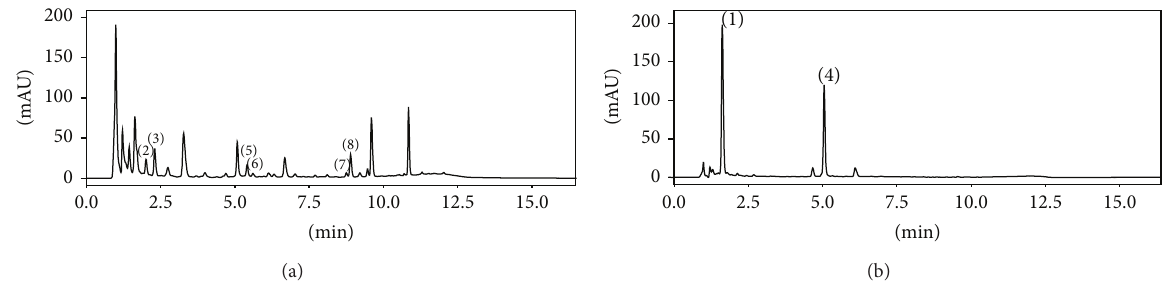
Figure 2: HPLC-DAD chromatograms of sesquiterpene lactones and chlorogenic acids in chicory root product (flour) obtained with H 2 O/CHCl 3 /MeOH 30/30/30 (v/v/v) extraction: (a) STL at 254 nm and (b) CGA at 320 nm. (1) 5-Mono- O -caffeoylquinic acid, (2) 11(S),13- dihydrolactucin, (3) lactucin, (4) 3,5-di- O -caffeoylquinic acid, (5) 11(S),13-dihydro-8-deoxylactucin, (6) 8-deoxylactucin, (7) 11(S), 13- dihydrolactucopicrin, and (8) lactucopicrin.